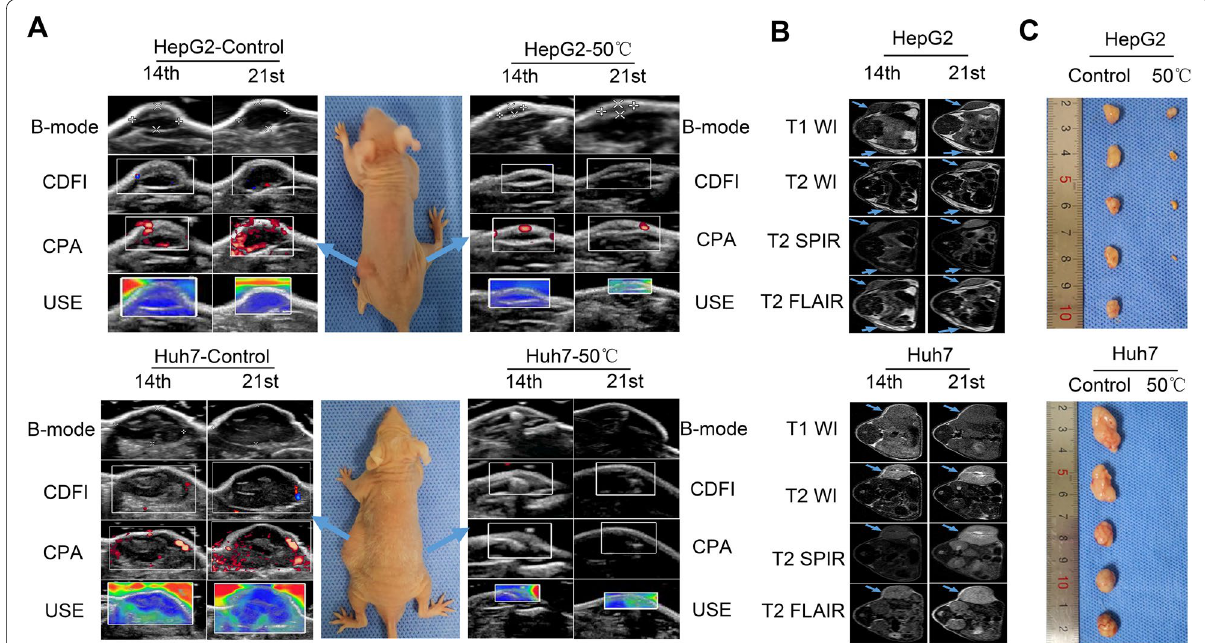
Fig. 6 Hyperthermia inhibits growth of HCC in vivo. A Representative images of tumors implanted with HepG2 and Huh7 cells by US imaging at the 14th and 21st day. (Left panel represents the control and right panel represents the 50 °C treatment, and arrows indicate US imaging of the corresponding tumors). B Representative images of tumors by MRI at the 14th day and 21st day. The arrows indicating the location of tumors. C The photographs of excised tumors at the 21st